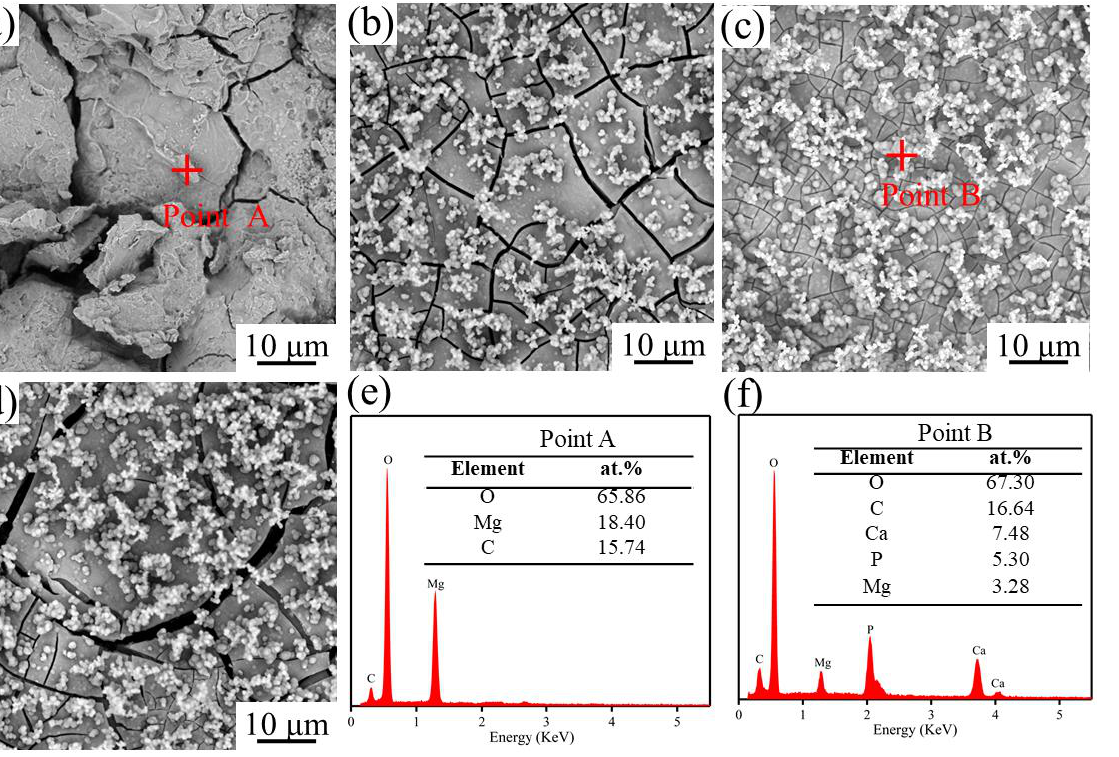
Figure 6. The morphology of the degradation product on the SLMed ZK60−xND after immersion in SBF: ( a ) SLMed ZK60; ( b ) SLMed ZK60−3ND; ( c ) SLMed ZK60−6ND; ( d ) SLMed ZK60−9ND; ( e ) in SBF: ( a ) SLMed ZK60; ( b ) SLMed ZK60 − 3ND; ( c ) SLMed ZK60 − 6ND; ( d ) SLMed ZK60 −